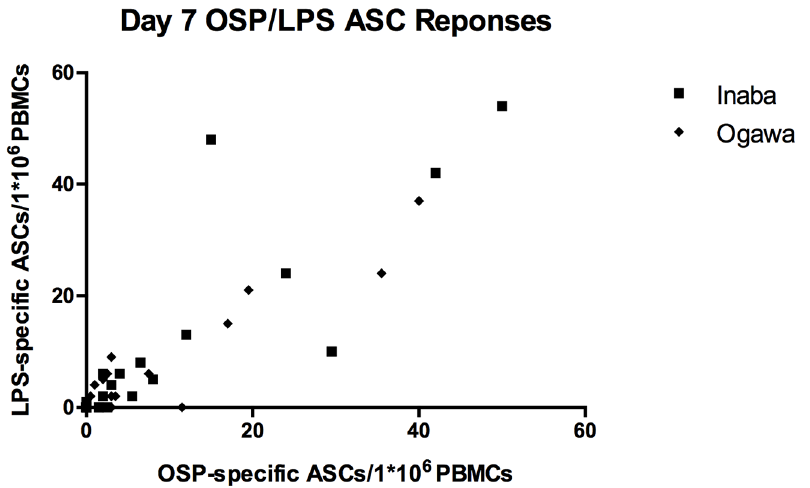
Fig 4. Correlation between Day 7 anti-OSP and anti-LPS ASC Responses. Ogawa: Spearman ’ s r = 0.7706, p < 0.0001. Inaba: Spearman ’ s r = 0.9030, p <